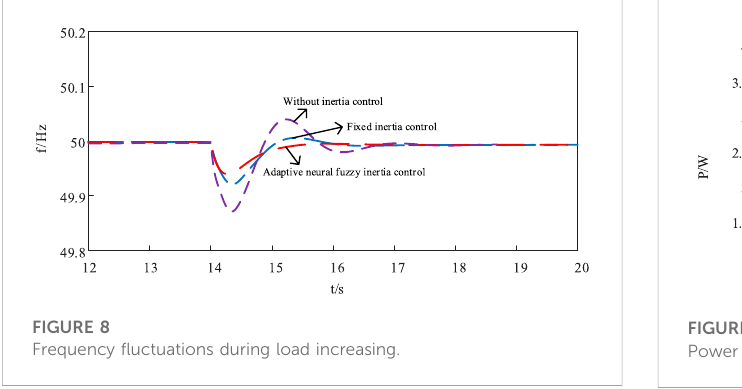
FIGURE 11 Power fl uctuations during load increasing.